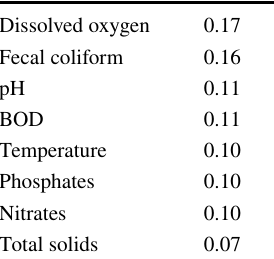
Table 5 Water quality